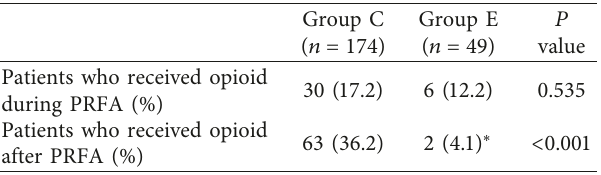
Table 2: Opioid consumption, during and after percutaneous radiofrequency ablation (PRFA).